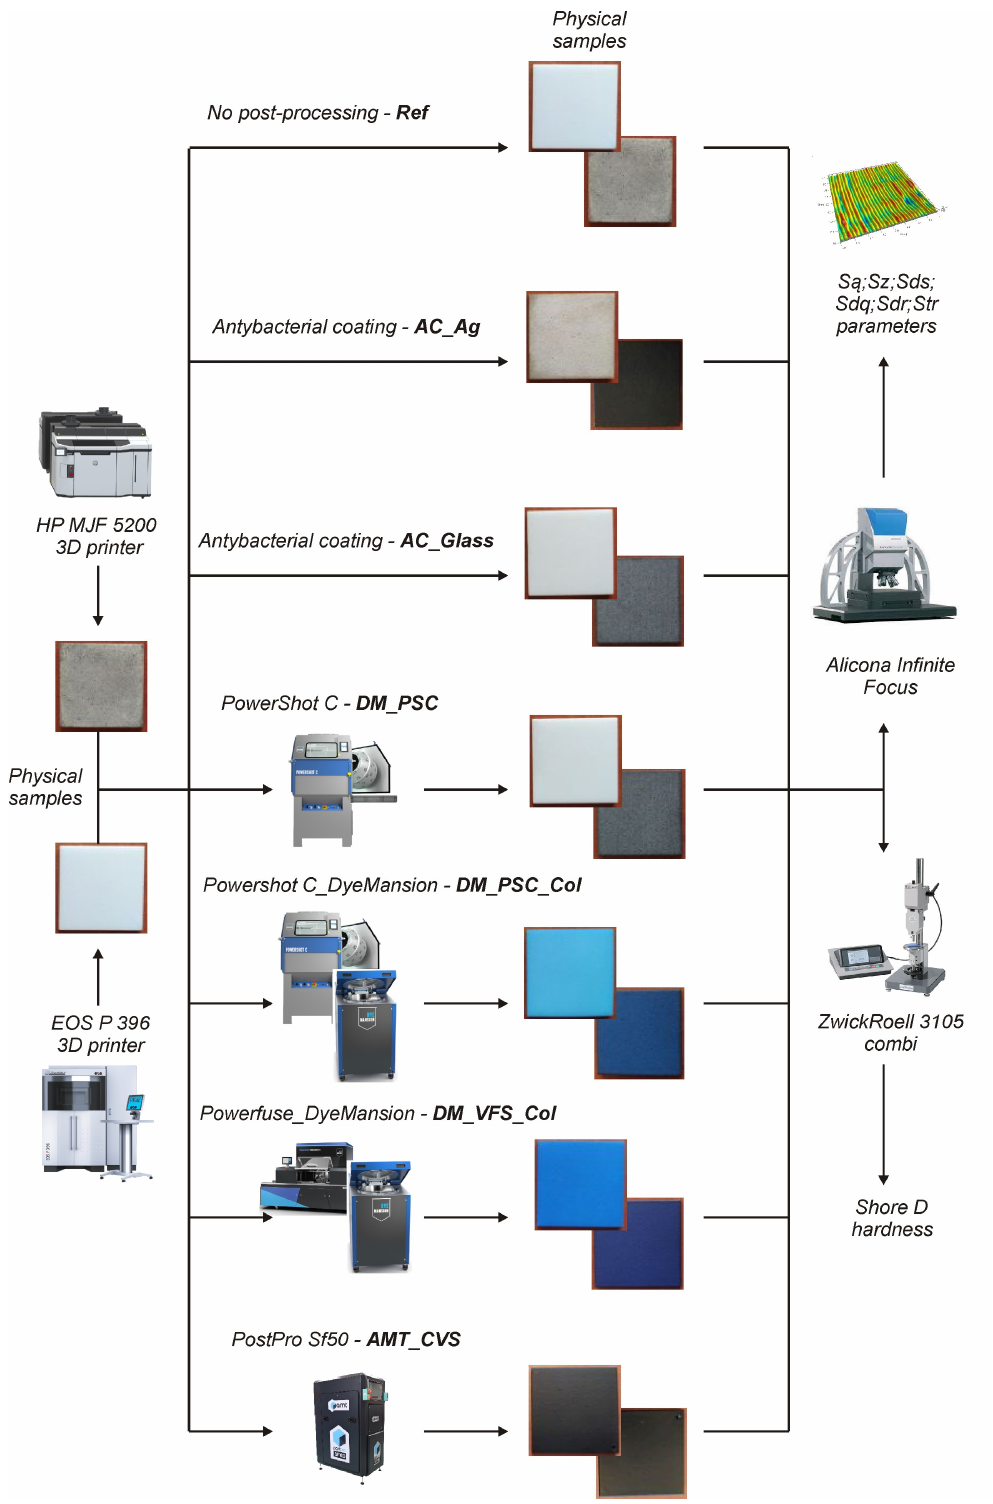
Figure 1. Scheme of